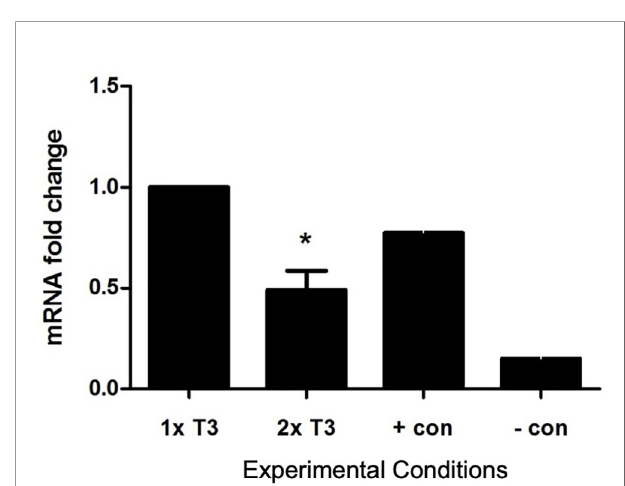
FIGURE 3 | Graph showing apoptosis in proangiogenic cells (PACs) after staining with Annexin V and 7-AAD. Data are represented as mean ± SEM. * p < 0.05 versus normal (1× T3) and n = 11. +con, positive control, − con, negative control.